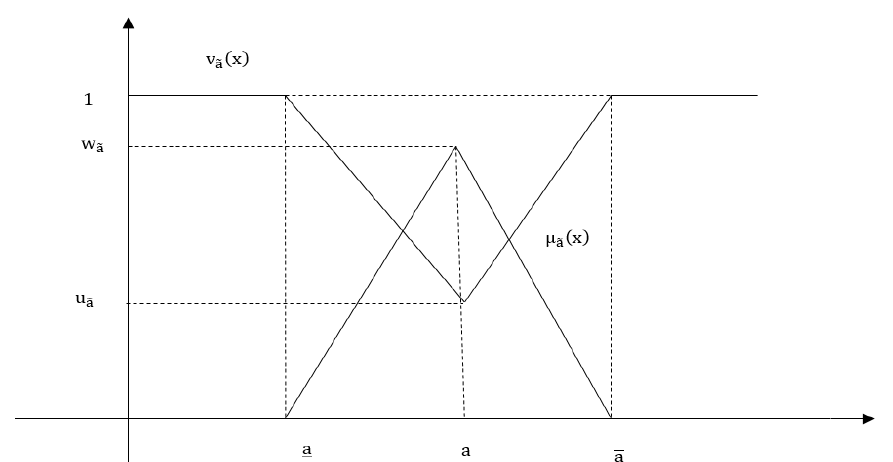
Fig. 2. Triangular intuitionistic fuzzy